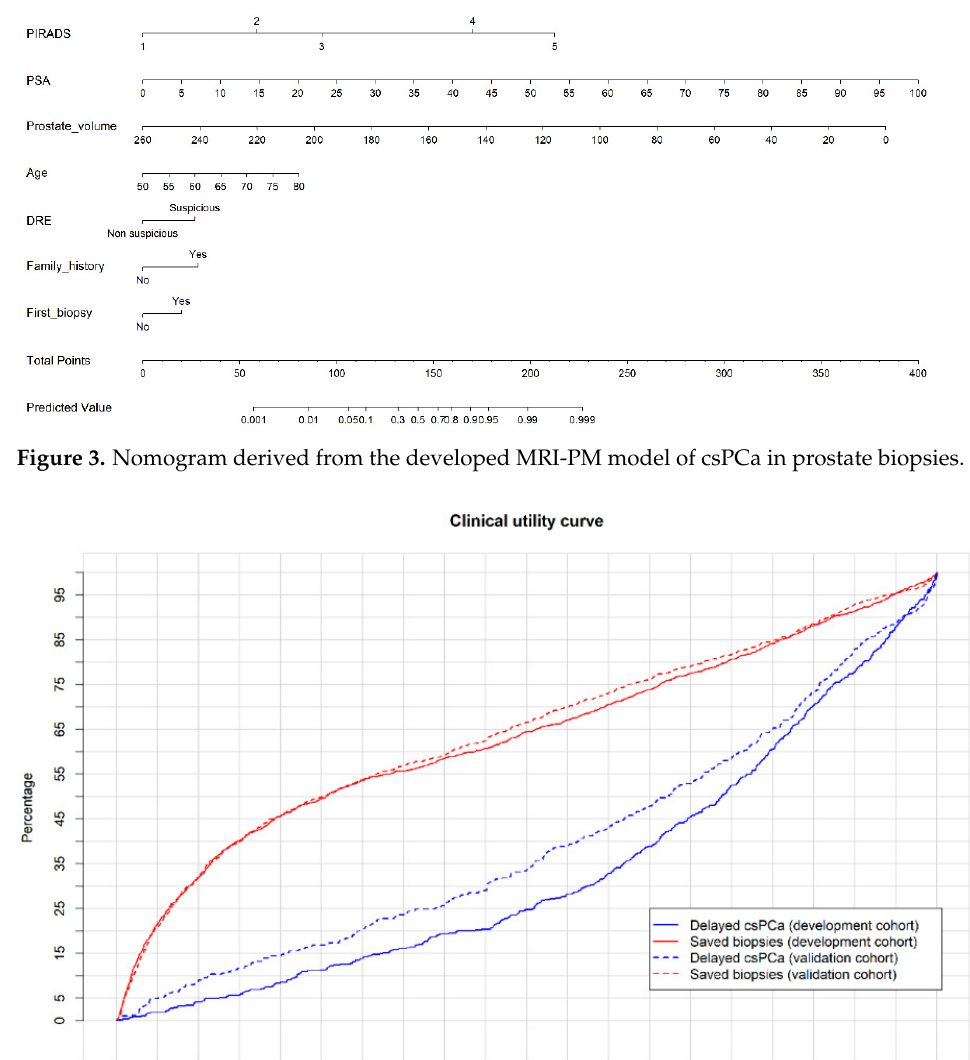
Figure 4. CUCs showing the rates of avoided biopsies (red lines) and corresponding missed csPCa (blue lines) regarding the continuous threshold of csPCa probability using MRI-PMs in develop- ment cohort (continuous lines) and external validation cohorts (interrupted lines).